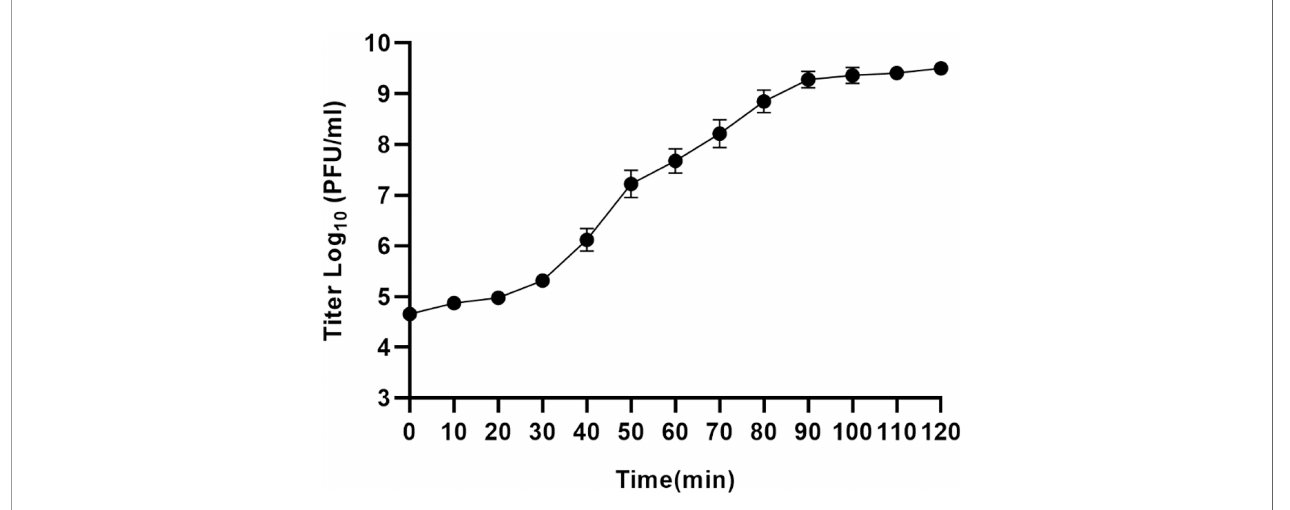
FIGURE 2 | One-step growth curve of vB_kpnM_17-11. The PFU of each infected cell is shown at different time points. Each data point represents the mean of three independent experiments, and the error bar represents the standard